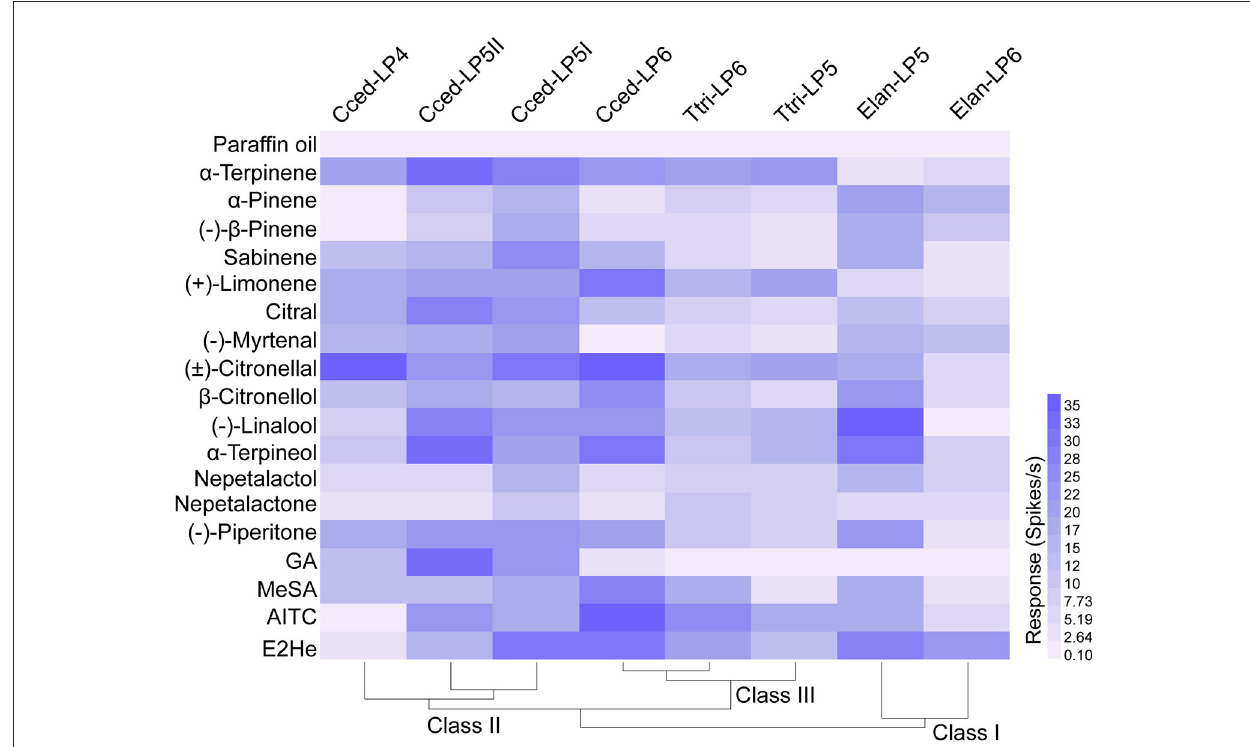
FIGURE4 Heat map of functional profiles of ORNs housed in primary rhinaria in C. cedri , E. lanigerum , and T. trifolii to the tested odorants. The response intensity of ORNs is color-coded according to the response values ( n = 4–16). The solvent paraffin oil was set as the control. Chemicals were listed in Table 1. E2He, trans -2-hexenal; MeSA, methyl salicylate; AITC, allyl isothiocyanate, GA, geranyl acetate.